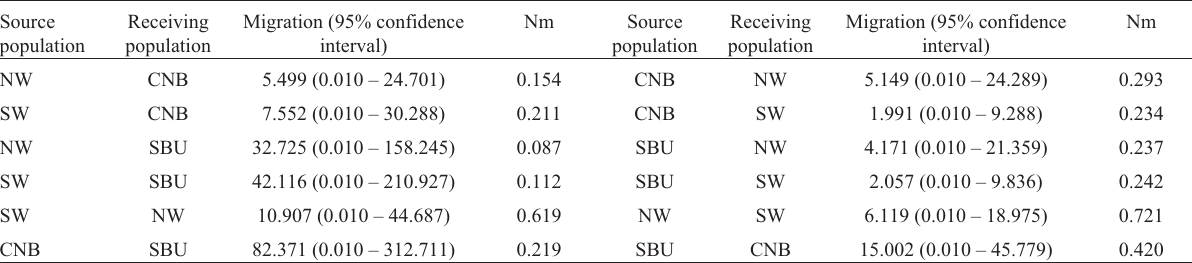
Table 3 - Estimation of migration rates between geographical populations of L. colocola based on mitochondrial DNA from data set B (DSB). Migration rate is scaled by mutation rate per site per generation. Nm is the estimated number of migrants entering a population per generation, and is obtained by multiplication of migration rates vs. theta for the receiving population. The left columns show the highest migration rates estimated for each pair of popu- lation, showing the predominant migration directions from western to eastern regions of South America, and from central and northeastern Brazil to southern Brazil and